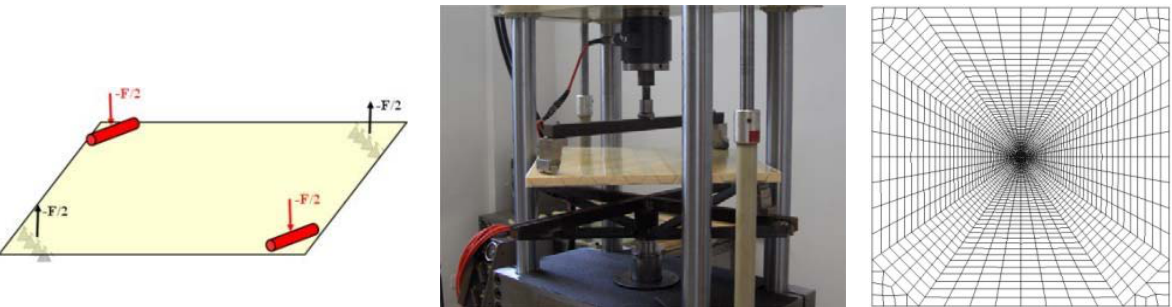
Figure 7: Determination of the torsional stiffness: loading scheme 1 (left), experimental setup (middle) and FEM model (right).